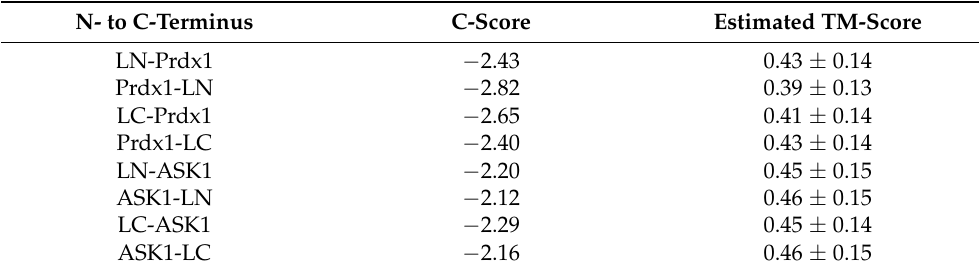
Table 1. Prdx1-mLumin and ASK1-mLumin fusion proteins do not present random similarity with the templates used for